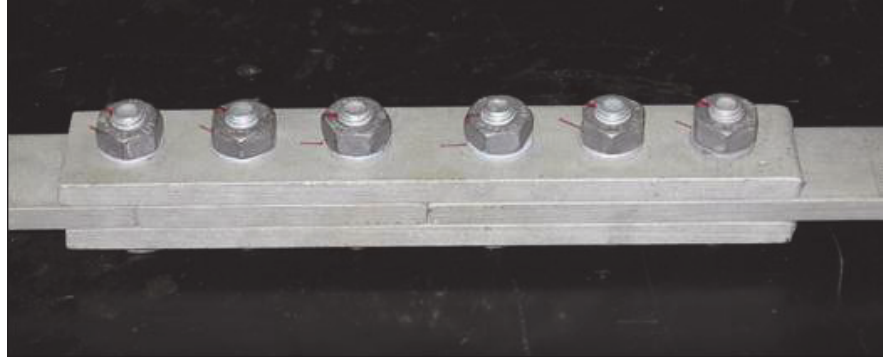
Figure 2: Hot-dip galvanized bolted connection before the test.